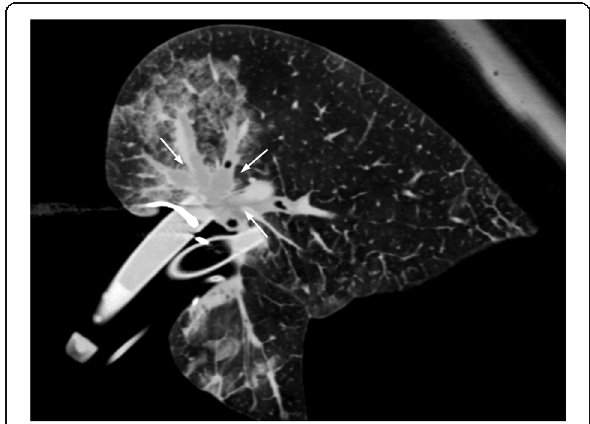
Fig. 6 Extensive central pulmonary embolism (white arrows) of the main pulmonary arteries and all segmental branches (case